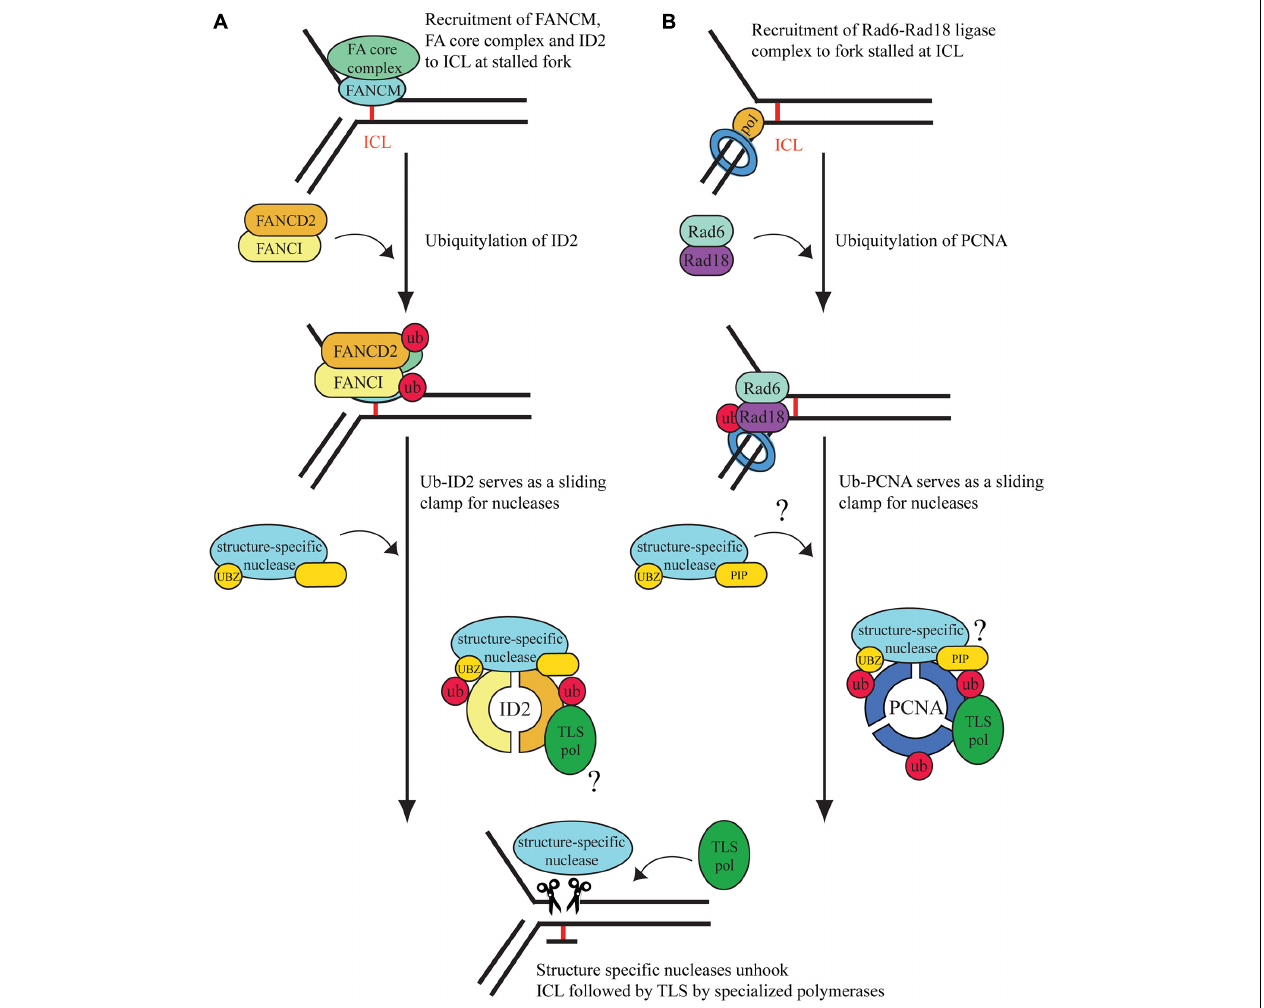
FIGURE 1 | Interstrand crosslink repair pathways at the stalled replication fork. (A) Replication-dependent ICL repair is considered to be carried out mainly by the Fanconi anemia pathway. After damage recognition, the ID2 complex is ubiquitylated by the activated FA core complex. The monoubiquitinated ID2 complex can further recruit structure-specific nucleases for unhooking. Gap filling is carried out by TLS polymerases, but the mechanism behind the recruitment of the polymerases is yet unknown. We hypothesize that Ub-ID2 serves as a DNA- encircling sliding clamp for TLS polymerases and nucleases. (B) When the ongoing DNA replication fork is blocked by DNA lesions, such as ICLs, upstream factors recognize it, and PCNA is monoubiquitinated by RAD6/RAD18. We hypothesize that monoubiquitinated PCNA acts as a hub for the recruitment of certain PIP box- and UBZ domain-containing structure-specific nucleases to unhook the ICL lesion. Translesion synthesis polymerases are also recruited to the site of damage by Ub-PCNA, which complete the bypass of the DNA damage. The covalent bond of the monoadduct is removed by nucleotide excision